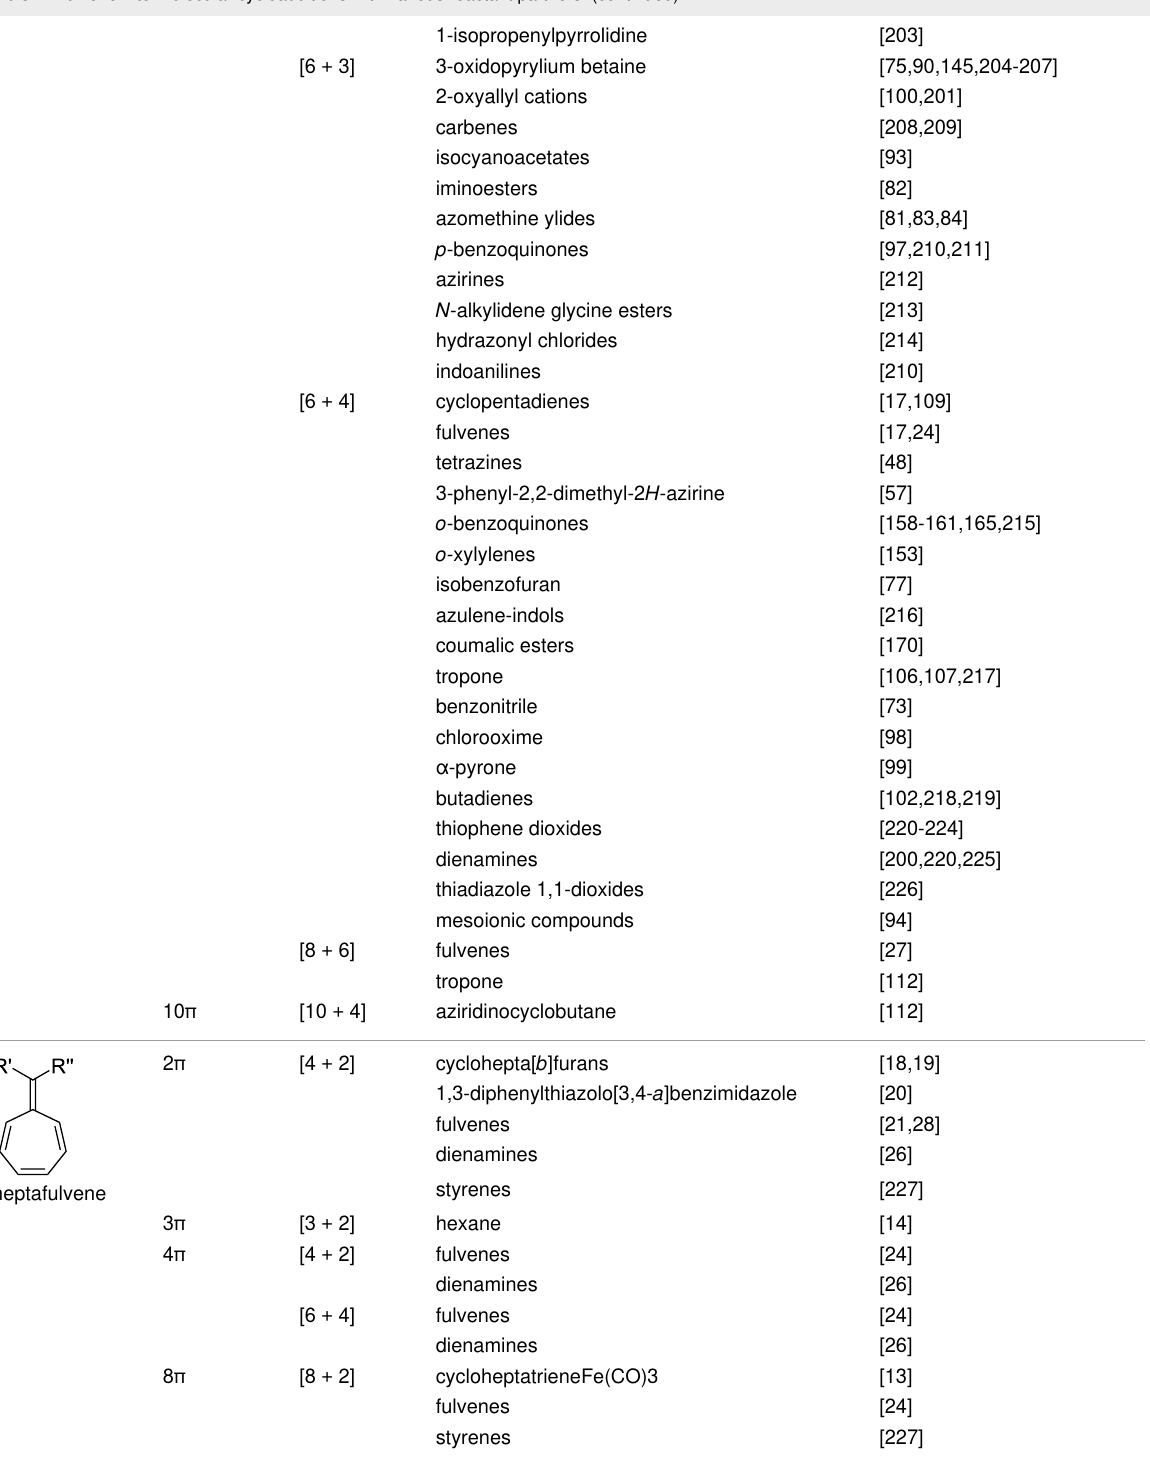
Table 2: Fulvene intermolecular cycloadditions with various reactant partners.